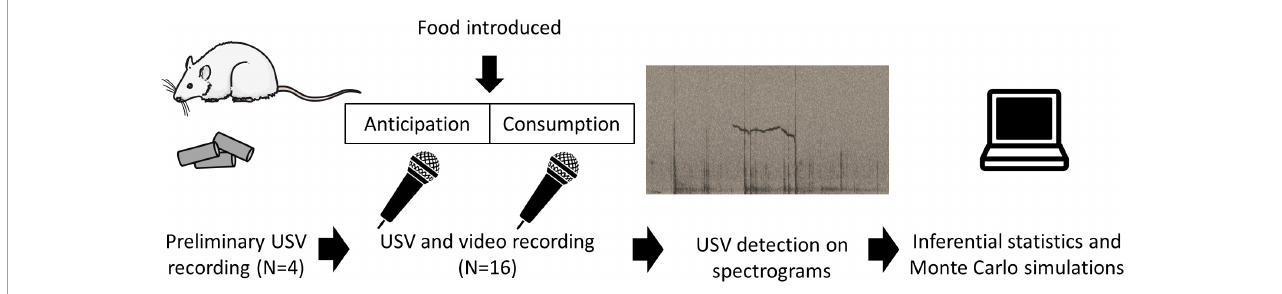
FIGURE1 Outline of the experimental procedure. Preliminary observations on four rats who were fed their usual pellets were used to optimise recording conditions. The USV data for this study were generated using 16 other rats went through a protocol described previously (Champeil-Potokar et al., 2021). Following a mild overnight food restriction, rats were recorded during the anticipation and consumption of an experimental meal. USVs were identified from spectrograms and data were analysed using Inferential statistics and Monte Carlo simulations.